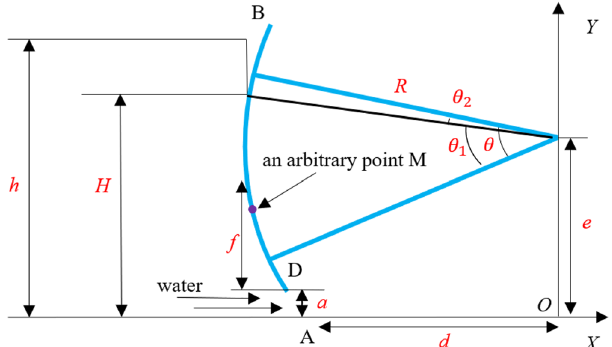
Figure 1. Theoretical model of hydrodynamic pressure of radial